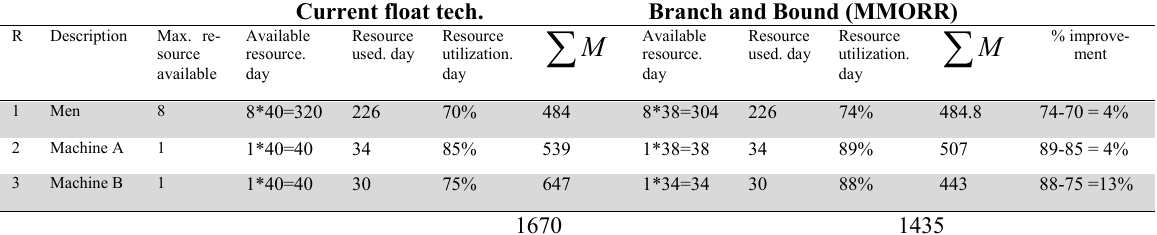
Comparison between current Float Tech. and the new model B & B (MMORR) after improving R3 Current float tech. Branch and Bound (MMORR) R Description Max. re-